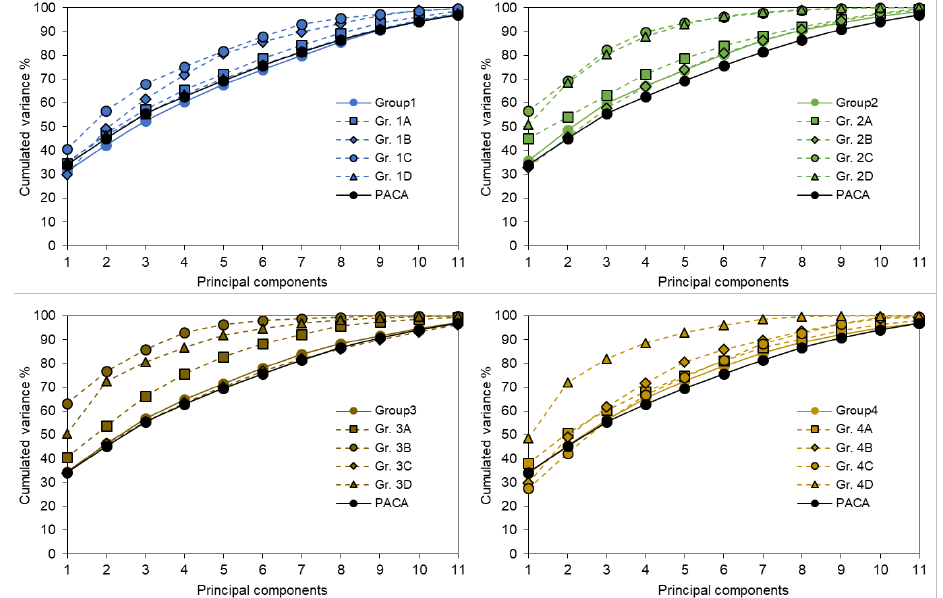
Figure 7. Distribution of the cumulative variance on the first 11 principal components for PCA performed on the regional dataset (PACA), groups 1 to 4 and subgroups.